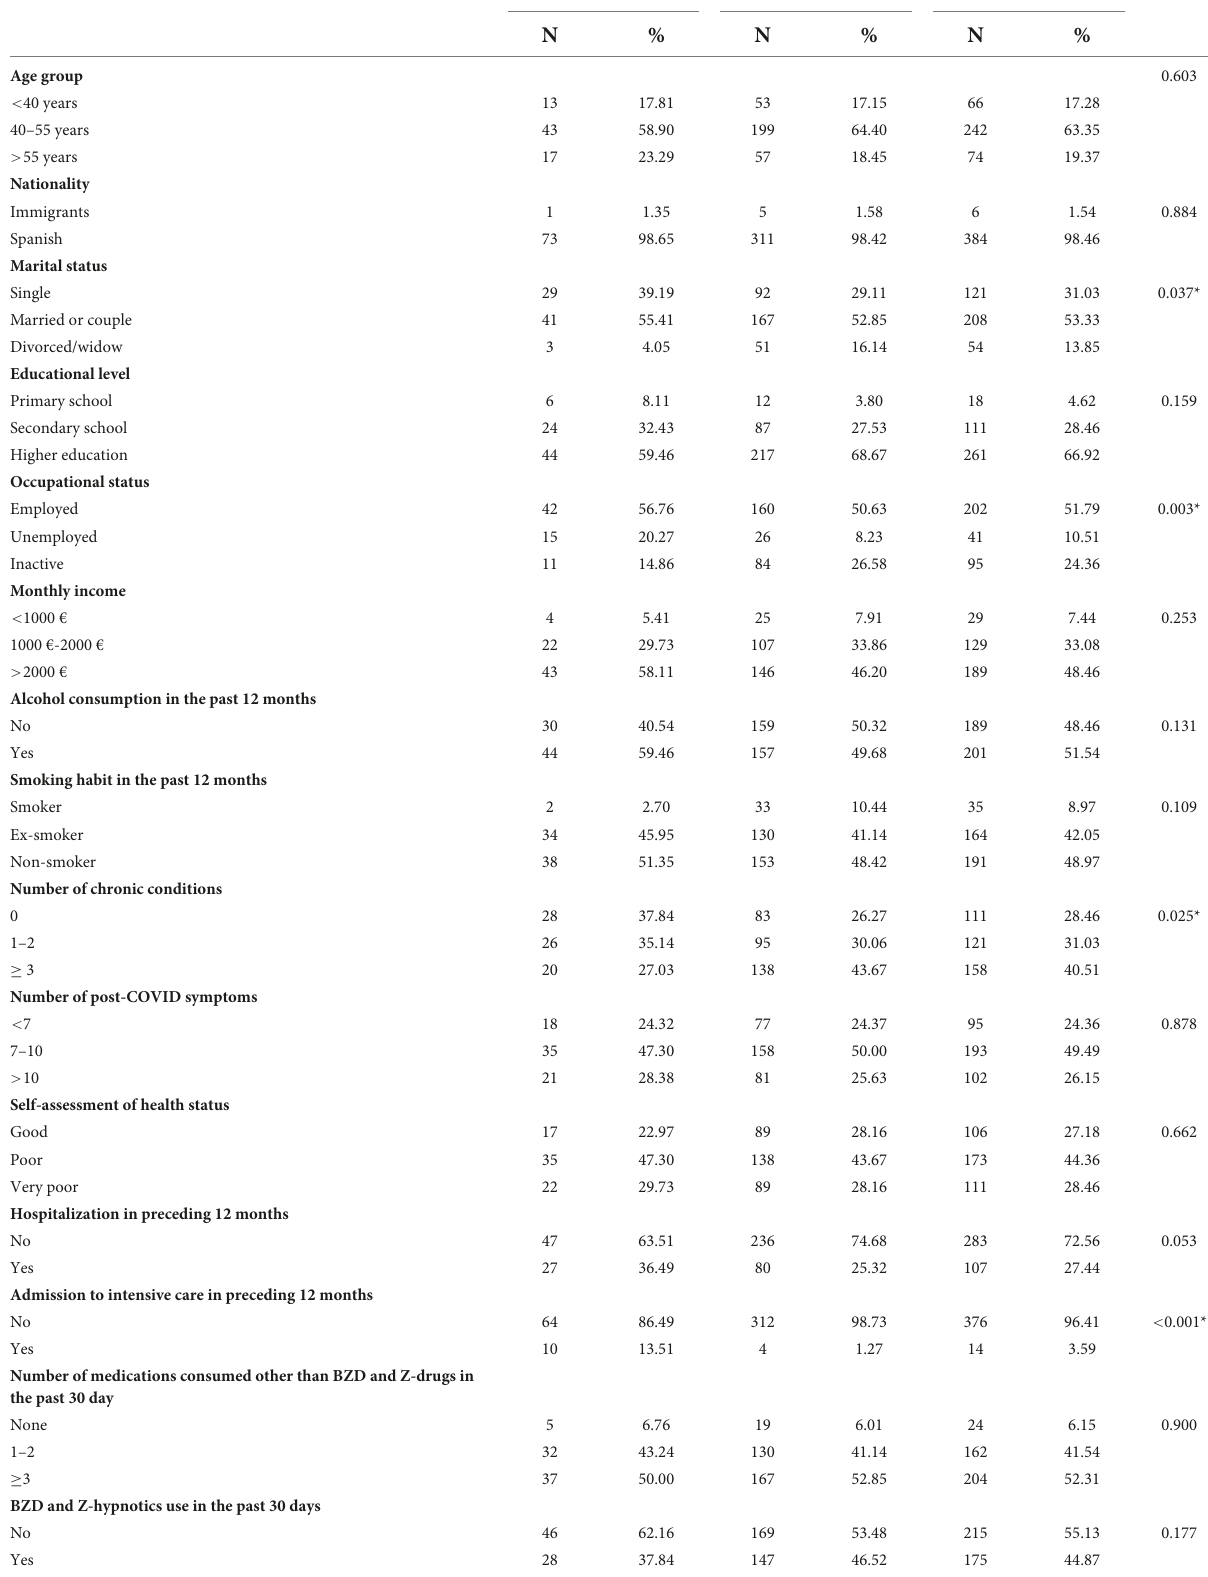
TABLE 1 Sample characteristics by gender for the total survey